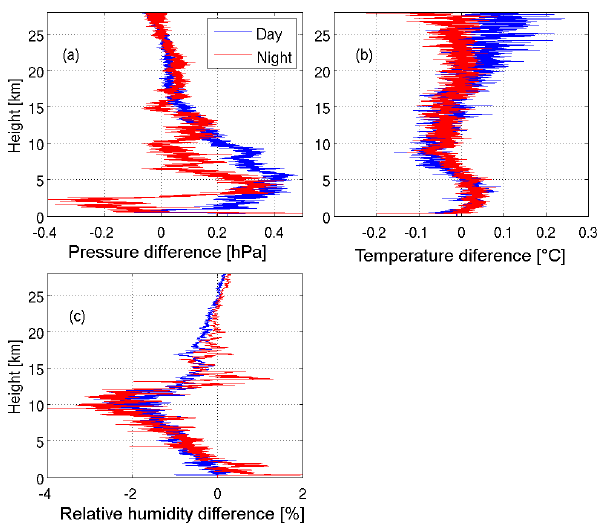
Figure 11. Differences between RS92 and RS41 radiosondes (RS92 − RS41) for daytime (blue) and nighttime (red) flights for (a) pressure, (b) temperature, and (c) relative humidity.